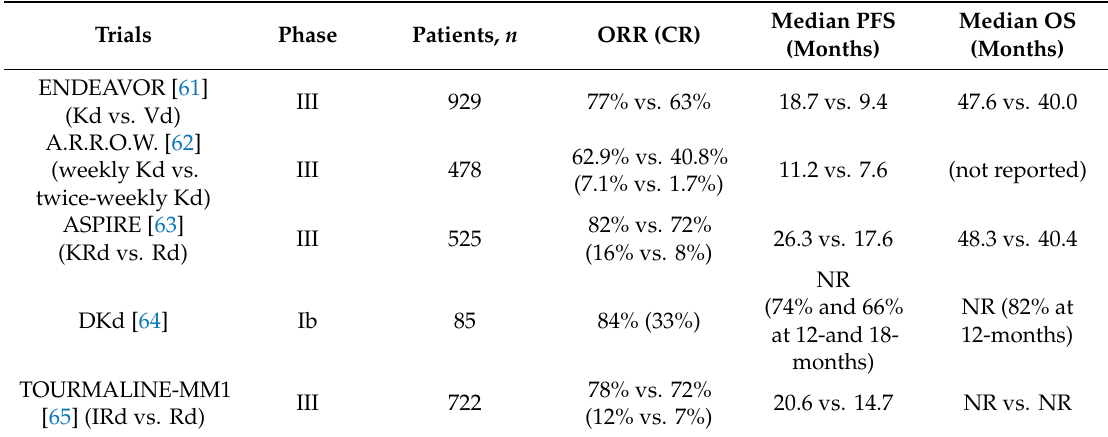
Table 4. Selected carfilzomib or ixazomib-containing regimens for relapsed and / or refractory MM. Trials Phase Patients,